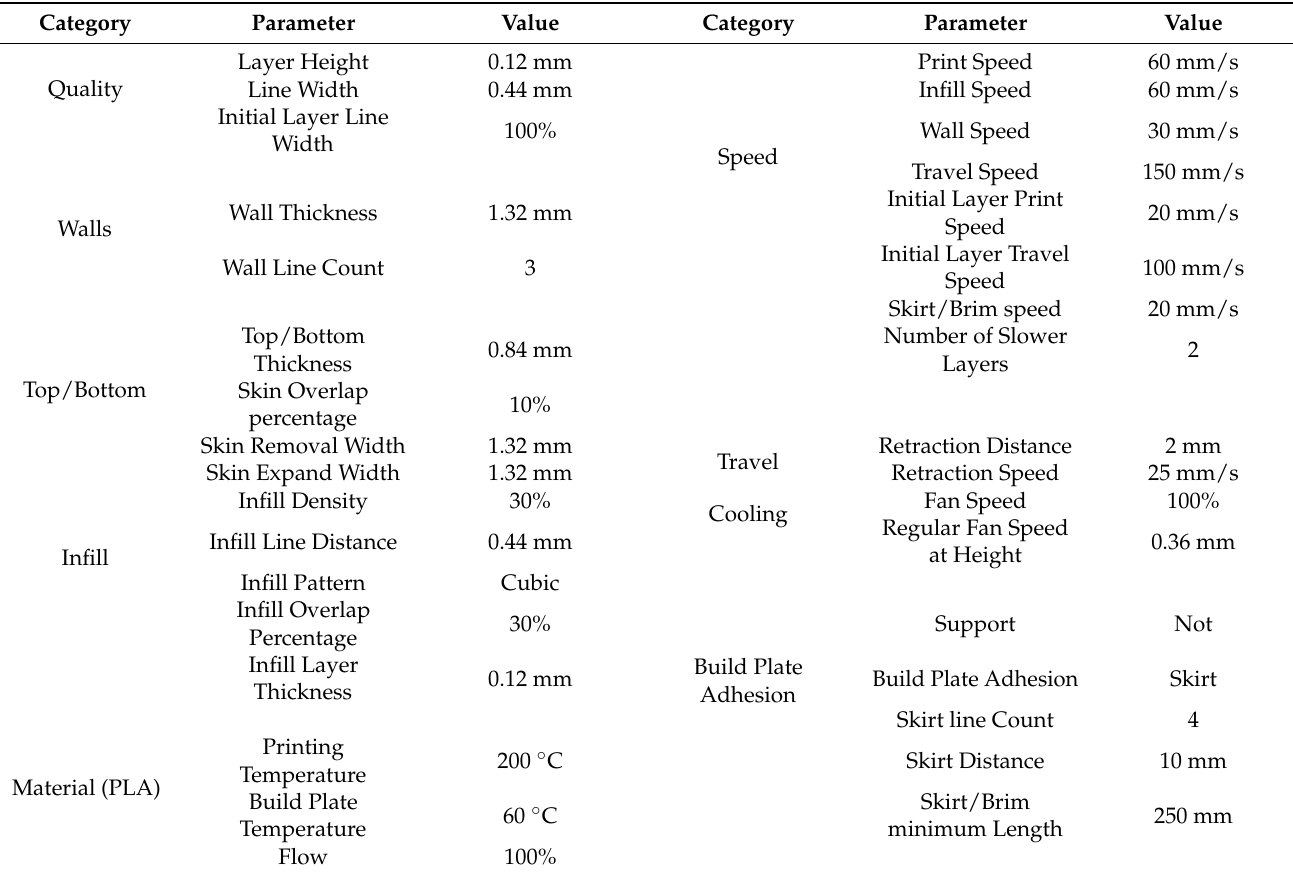
Table 3. Parameters used for the 3D-printing of the PLA mouthpiece.